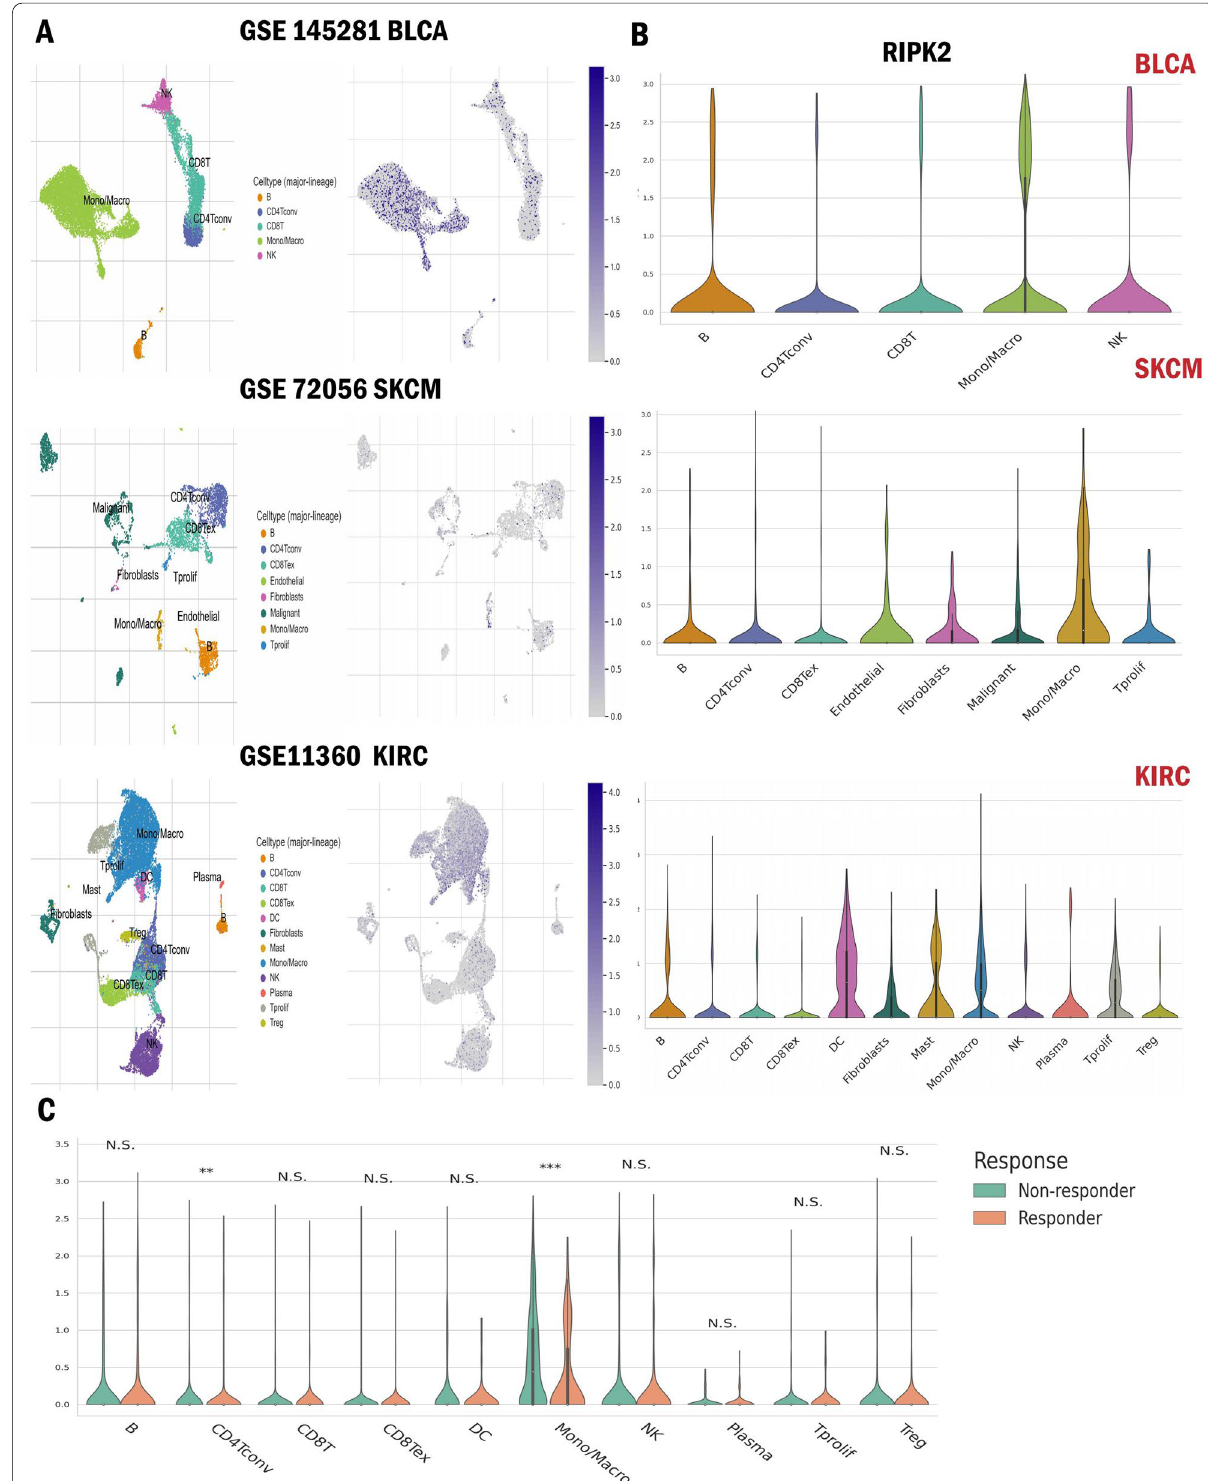
Fig. 7 Expression level of RIPK2 at the single-cell stage. A UMAP graphs showed cellular clusters and the expression level of RIPK2 in different cellular types of BLCA, SKCM, and KIRC. B Single-cell RIPK2 expression profile of different cellular types in BLCA, SKCM, and KIRC. C Comparison of single-cell RIPK2 expression profile of immunotherapy non-responder with